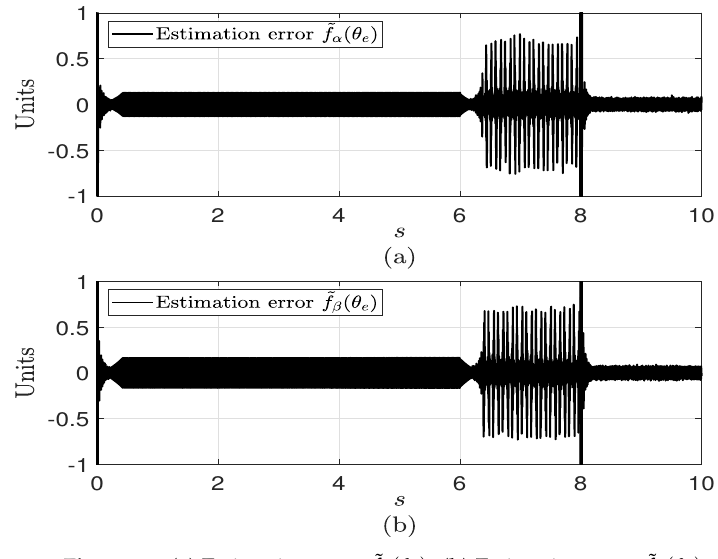
Figure 18. ( a ) Estimation error ˜ f α ( θ e ) . ( b ) Estimation error ˜ f β ( θ e ) .